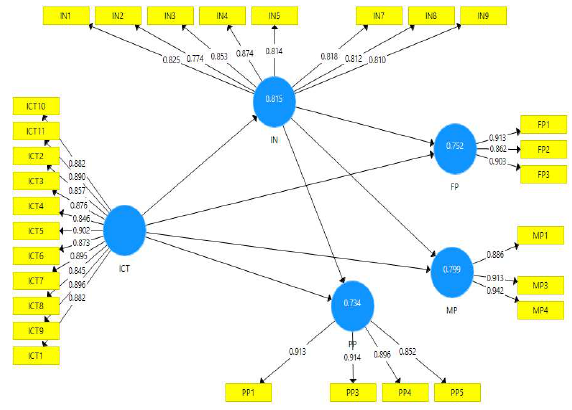
Fig. 2. Measurement Model